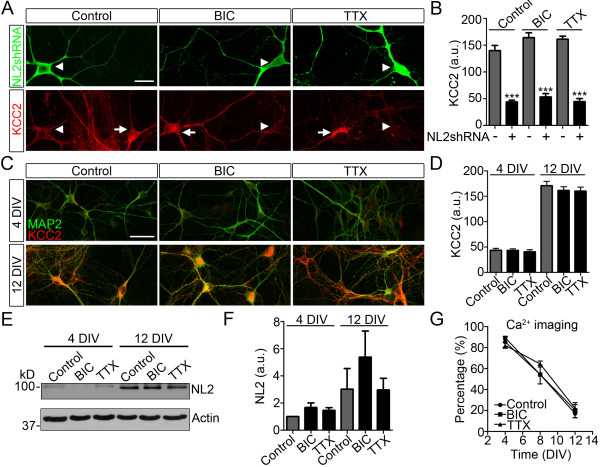
Regulation of KCC2 by NL2 is independent of GABAA receptor function or neuronal activity. A, Representative images showing reduced KCC2 immunostaining (red) in neurons transfected with NL2shRNA (green, arrowheads, 11 DIV), regardless whether treated with BIC or TTX. DMSO (0.1%, Control), BIC (20 μM) or TTX (1 μM) was added into culture medium after transfection at 2 DIV and replenished every two days. Scale bar, 20 μm. B, Bar graphs showing somatic KCC2 immunofluorescence intensity in neurons with (+) and without (-) NL2shRNA transfection (n = 11–12 neurons per group). Cultures were treated with DMSO (Control), BIC or TTX after transfection. ***p < 0.001, unpaired Student’s t-test. C, Representative images showing MAP2 (green) and KCC2 (red) immunostaining at 4 and 12 DIV in neurons treated with DMSO, BIC or TTX, starting at 2 DIV. Scale bar, 20 μm. D, Bar graphs showing developmental increase of the somatic KCC2 immunofluorescence intensity (n = 12 neurons per group). a.u., arbitrary unit. E, Representative immunoblot showing NL2 expression in 4 and 12 DIV neurons treated with DMSO, BIC or TTX, starting at 2 DIV. Actin was used as loading control. F, Quantification of NL2 expression level as measured by immunoblot (n = 3 independent cultures). NL2 expression was normalized to the expression level of 4 DIV control. G, Calcium imaging showing the time courses of GABA functional switch in control neurons and neurons treated with BIC or TTX (3 independent cultures; n = 1141, 717, 737 neurons, respectively).